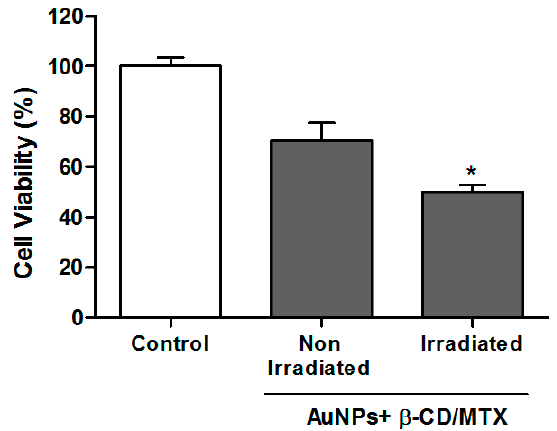
Figure 10. Test of the viability of the HeLa cells treated with AuNPs + β -CD/MTX, previously irradiated for 15 min with a 532-nm laser (50 mW). The HeLa cells were incubated for 1 h with AuNPs + β -CD/MTX (0.1 mM) (irradiated and nonirradiated) samples. After 71 h, cell viability was determined through MTS assay. The results are expressed as percentages compared with untreated cells and represent the mean and SEM of the three independent experiments in triplicate (* p < 0.05).